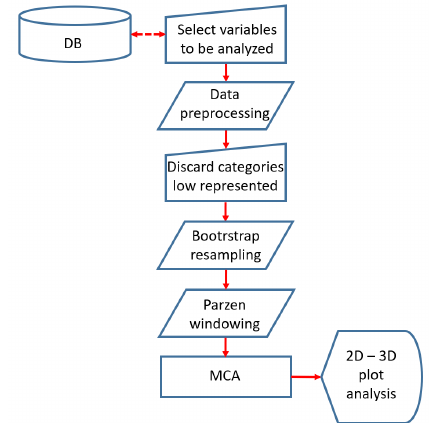
Figure 4. Flowchart of the extended Multiple Correspondence Analysis (MCA) applied to the emergency Data Base